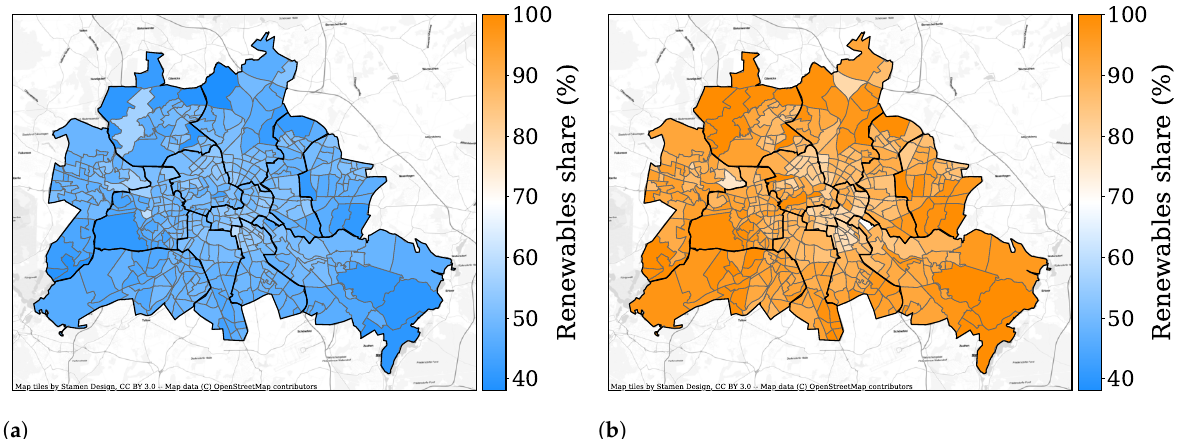
Figure 9. Spatial distribution of the share of energy demand met by renewables in Berlin